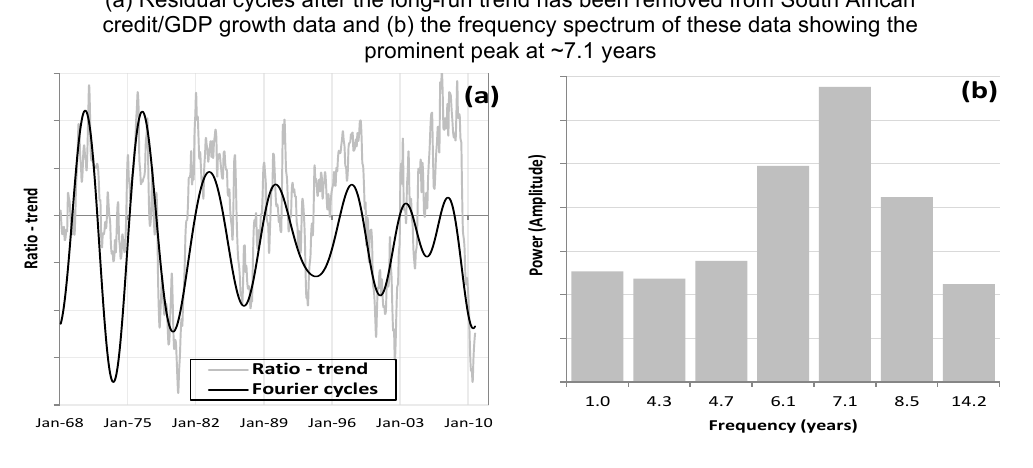
credit/GDP growth data and (b) the frequency spectrum of these data showing the prominent peak at ~7.1